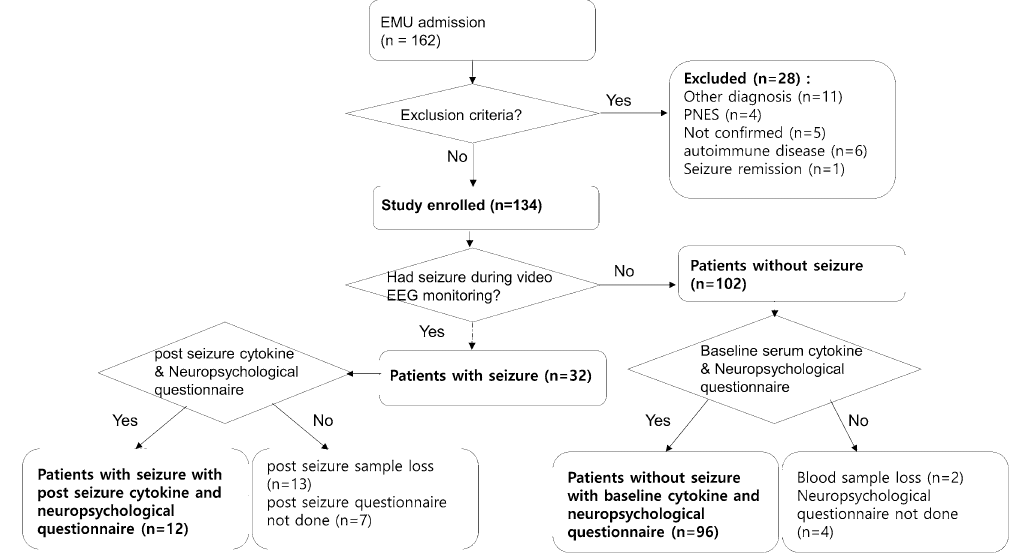
Figure 1. The selection of study subjects among the epilepsy patients. From epilepsy patients who were admitted for video EEG monitoring between July 2019 and December 2020 (n = 162), 134 patients were enrolled. Among them, 32 patients (32.9%) had seizure during the video EEG monitoring and 12 patients had post-seizure cytokine samples and neuropsychiatric questionnaires. Among patients who did not have seizure during video EEG monitoring (n = 102), 96 patients had neuropsychiatric questionnaires and serum cytokine tests.